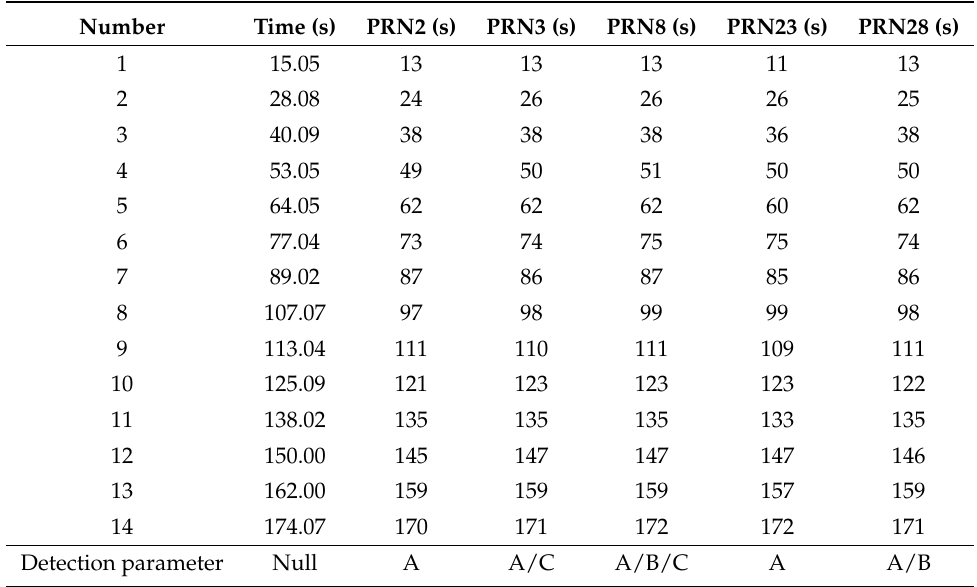
Table 5. Target detection time results from the BeiDou satellite reflected signals: (A) I branch component data; (B) phase difference information; (C) carrier-to-noise